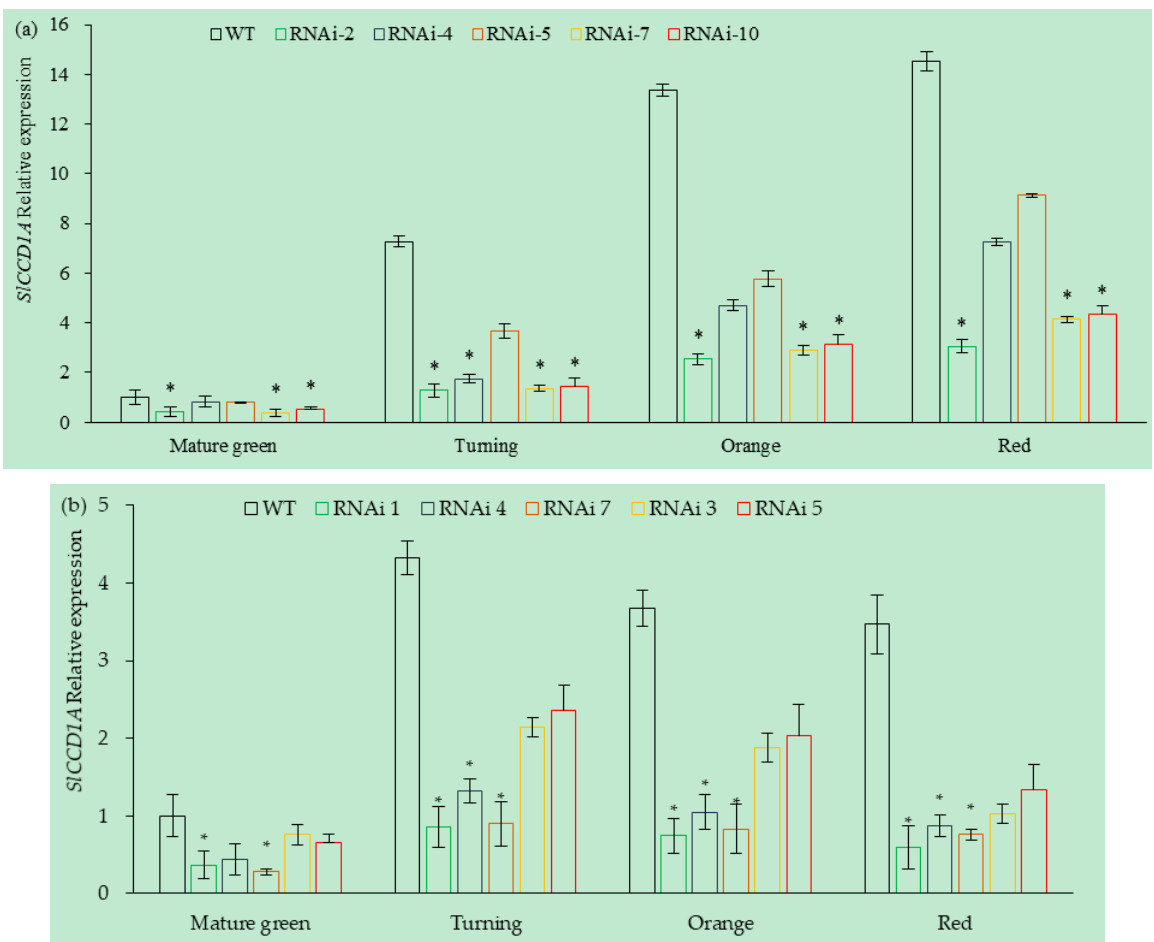
Figure 10. Relative expressions of SlCCD1A in RNAi transgenic tomato fruits in ( a ) CI1005 and ( b ) TI4001. WT: pCAMBIA1300 empty vector; * indicates that SlCCD1A expression was significantly lower in RNAi lines than in WT ( p < 0.05).